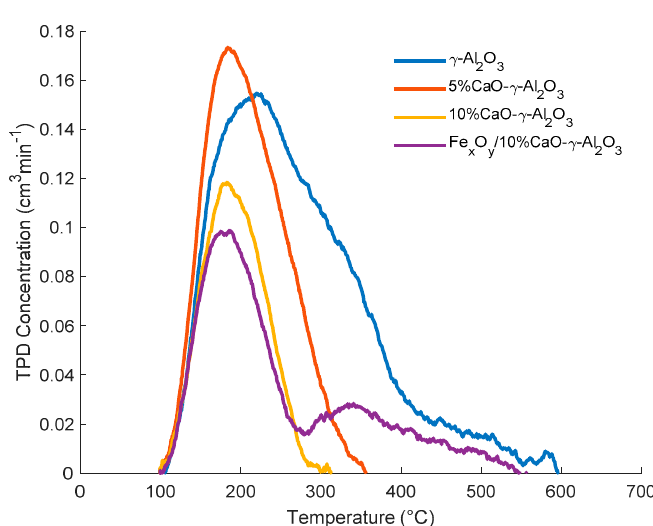
Catalysts 2020 , 10 , x FOR PEER REVIEW 7 of 32 Figure 3. NH 3 -TPD for γ -Al 2 O 3 ; 5% CaO- γ -Al 2 O 3 ; 10 -CaO- γ -Al 2 O 3 ; Fe x O y /10% CaO- γ -Al 2 O 3 catalysts.